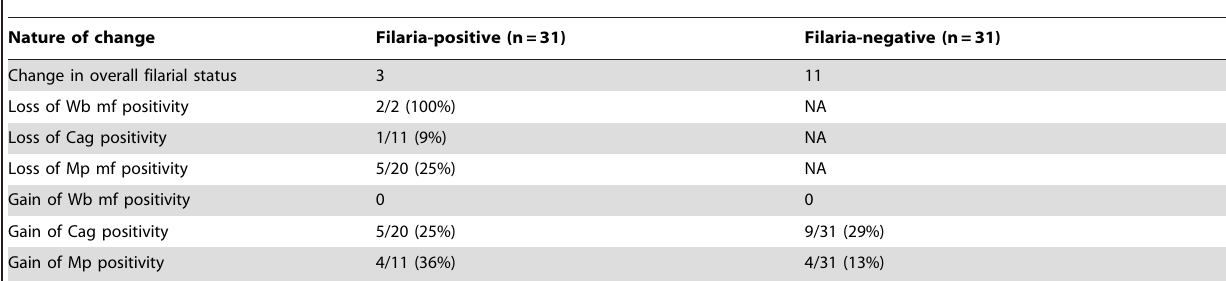
Table 2. Changes in filarial status over the course of the study.